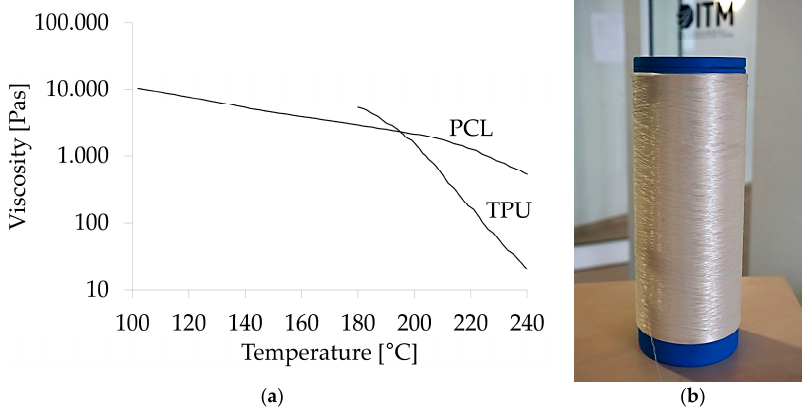
Figure 1. Viscosity-temperature curves of PCL and TPU ( a ) and spool of melt spun shape memory yarn blend type 70 / 30 ( b